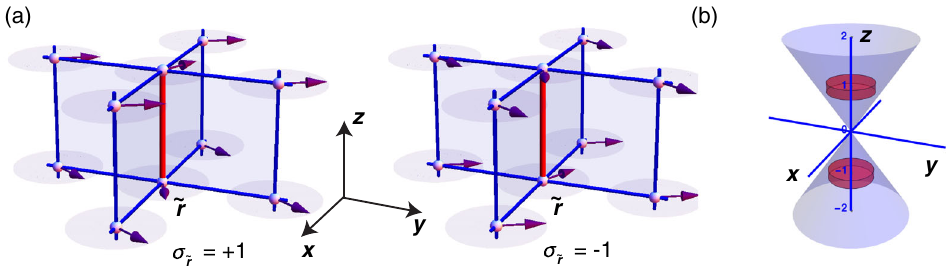
FIG. 3. (a) Sketch of the two ground states of Hamiltonian (1) for a single bilayer, in the presence of a single frustrating impurity bond (red line). For visualization purposes, the spins on every other site in the ab plane have been reversed so that the unfrustrated ground state looks ferromagnetic. The two ground states break the local inversion symmetry and correspond to counterclockwise (left panel) and clockwise (right panel) rotation of the spins as one proceeds along the c axis. They can be labeled by an Ising variable σ ~ r . Spin waves mediate an effective interaction Γ ~ r ; ~ r 0 between the local orientations σ ~ r and σ ~ r 0 of the cantings around two impurity bonds h ~ r ; ~ r þ z i and h ~ r 0 ; ~ r 0 þ z i , as given by Eq. (6). (b) The blue cone is the domain of Δ ~ r ¼ ~ r − ~ r 0 for which the effective interaction Γ ~ r ; ~ r 0 is excludes the domains represented by the antiferromagnetic, while outside the cone, it is ferromagnetic. The short-range constraint ξ min red cylinders and thus increases the probability of a ferromagnetic coupling between neighboring Ising